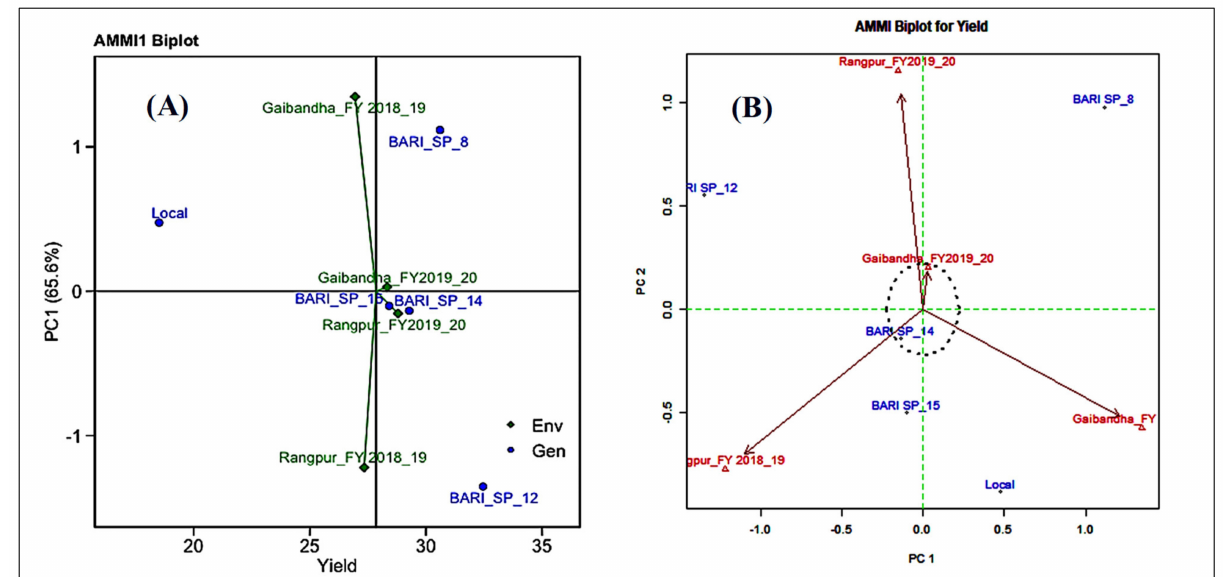
Figure 2. ( A ) AMMI 1 and ( B ) AMMI 2 biplot of IPCA1 (Interaction Principal Component Axes for genotype) axis against the mean yield of five sweet potato varieties evaluated in Gaibandha and Rangpur for tubers yield in sweet potato during 2018–2019 and 2019–2020 in Bangladesh.